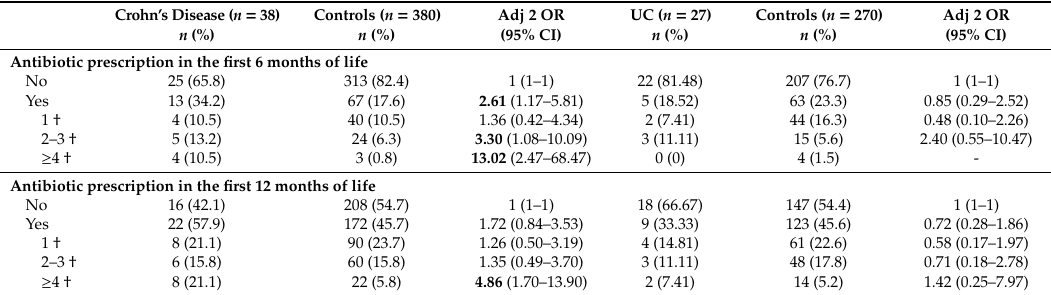
Table 5. Risks of antibiotic exposure in the first 6 and 12 months of life, in the development of Crohn’s disease and ulcerative